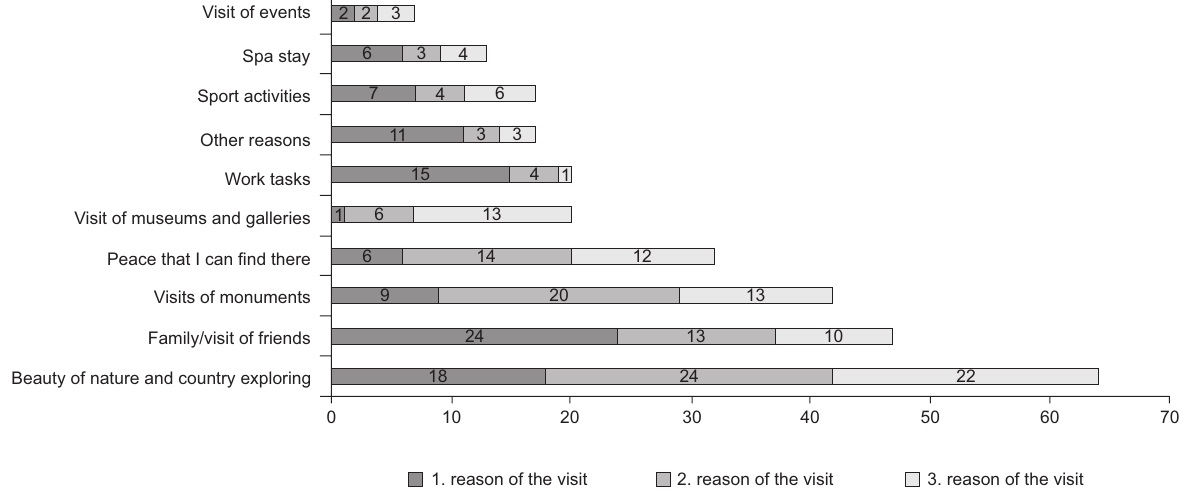
Fig. 2. Purpose of tourist visits in the Banská Bystrica region in 2013. Source: own research.